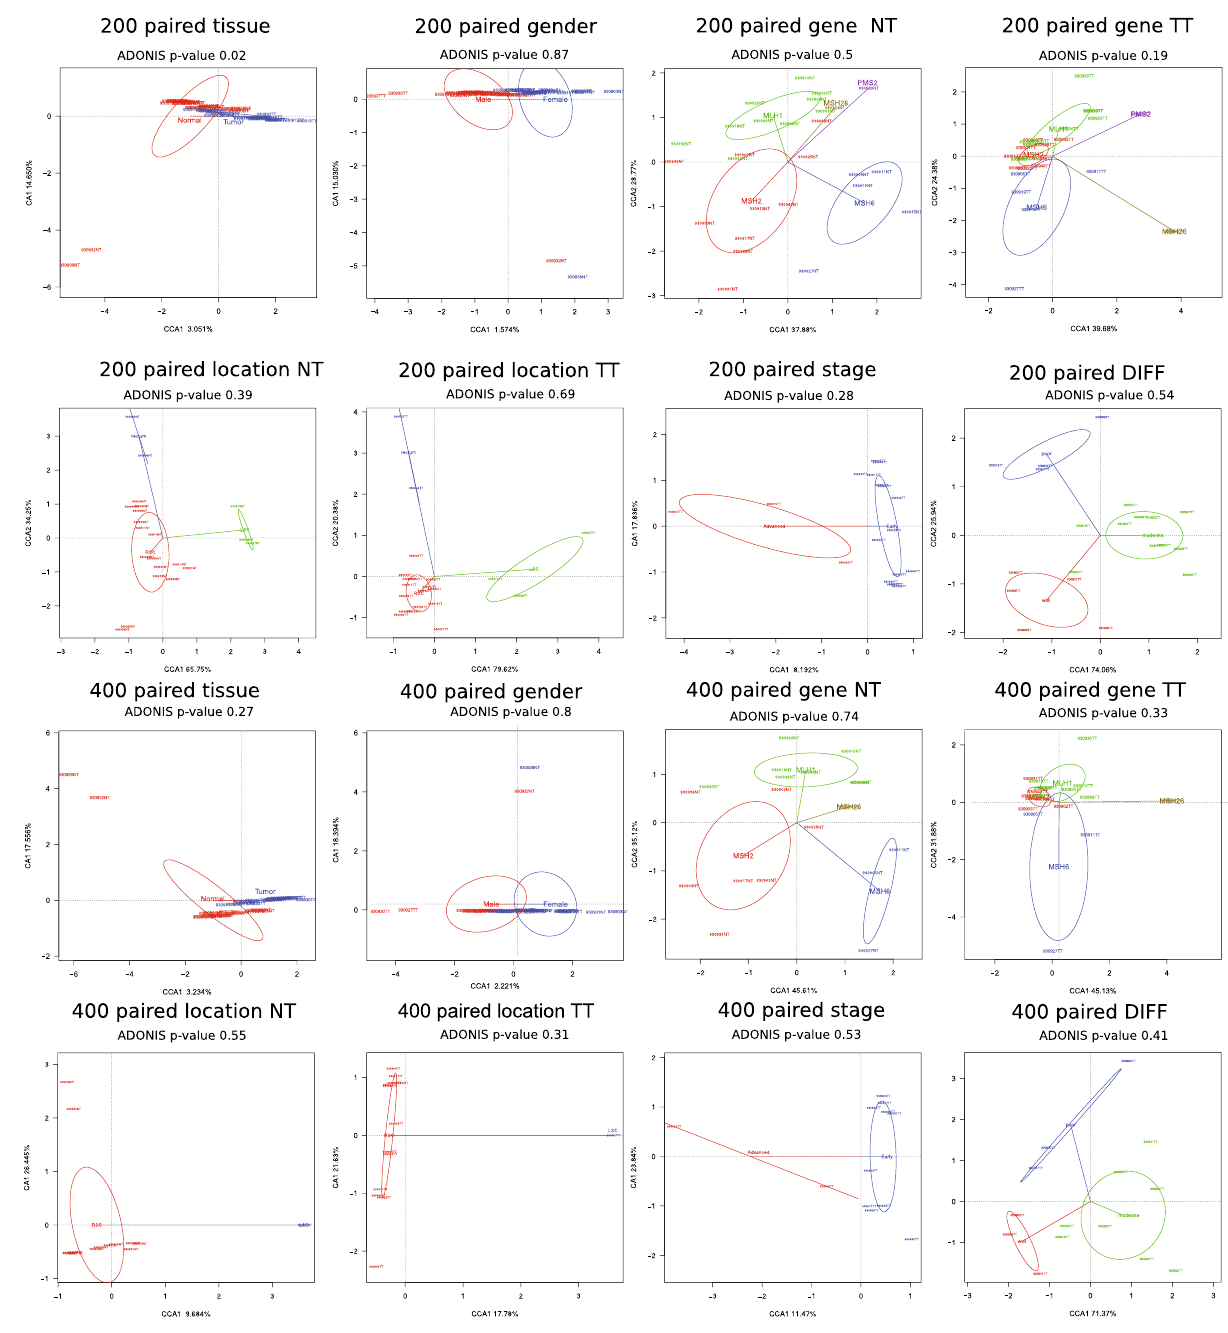
Figure 2. Taxonomic ecological beta diversity analysis by: tissue, gender, mutated gene, tumor location, stage and grade of differentiation. Analyses are shown for paired-only samples with more than 200 and 400 reads. Diversity among samples is shown through canonical correspondence analysis (CCA) and Adonis tests for significance. NT: normal tissue, TT: tumor tissue, DIFF: grade of